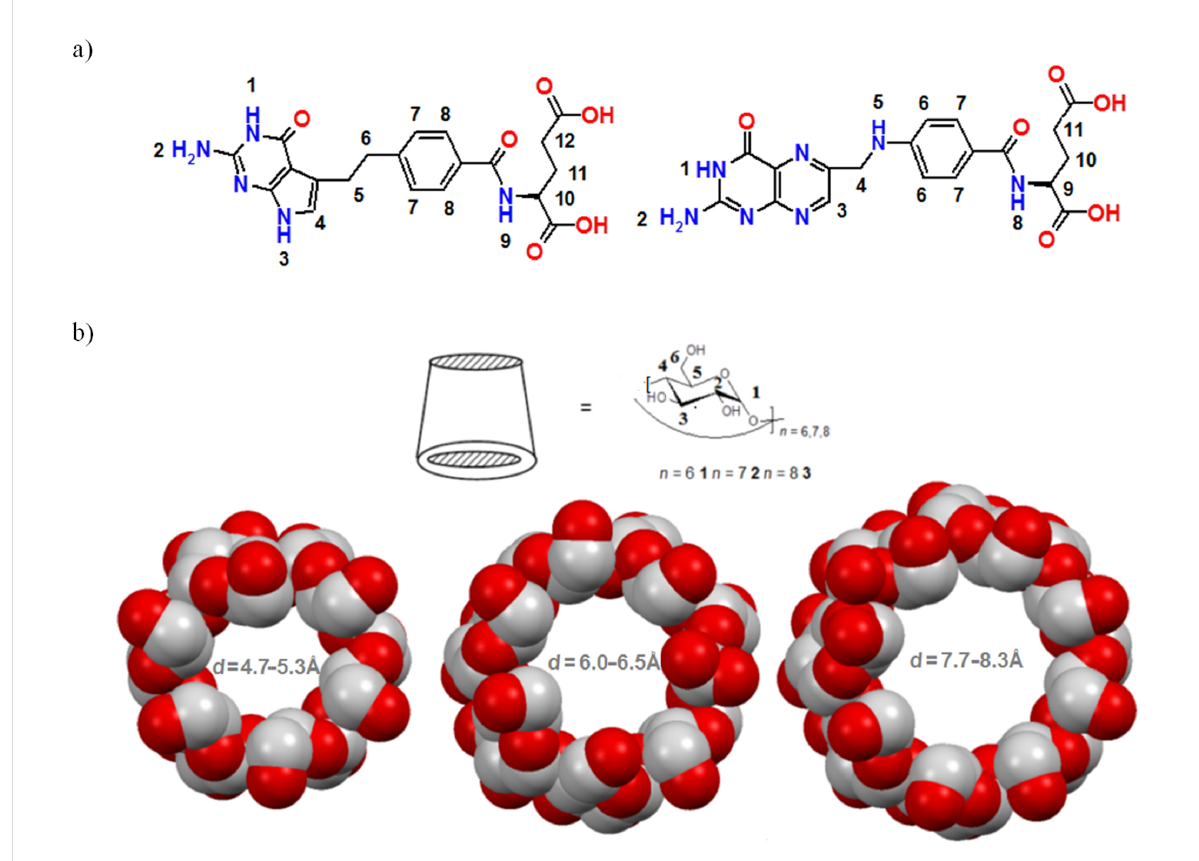
Figure 1: Molecular structures with atom numbering of the guest (a: from left to right): pemetrexed (PTX) and folic acid (FA), and host molecules with increasing diameter of macrocyclic cavity (b: from left to right: α -, β - and γ -CDs).